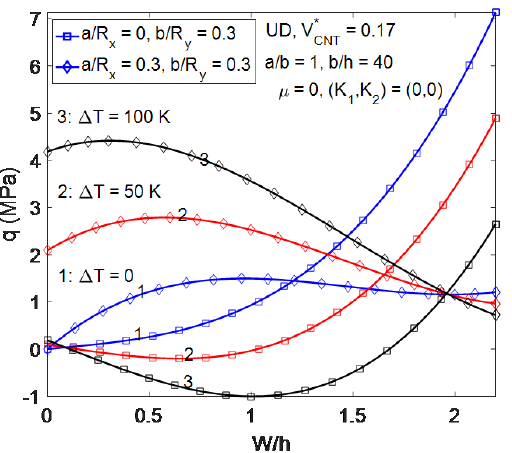
Fig. 15: Effects of CNT volume fraction and elastic foundation on the nonlinear thermomechanical response of FG-CNTRC spherical panels with immovable edges.